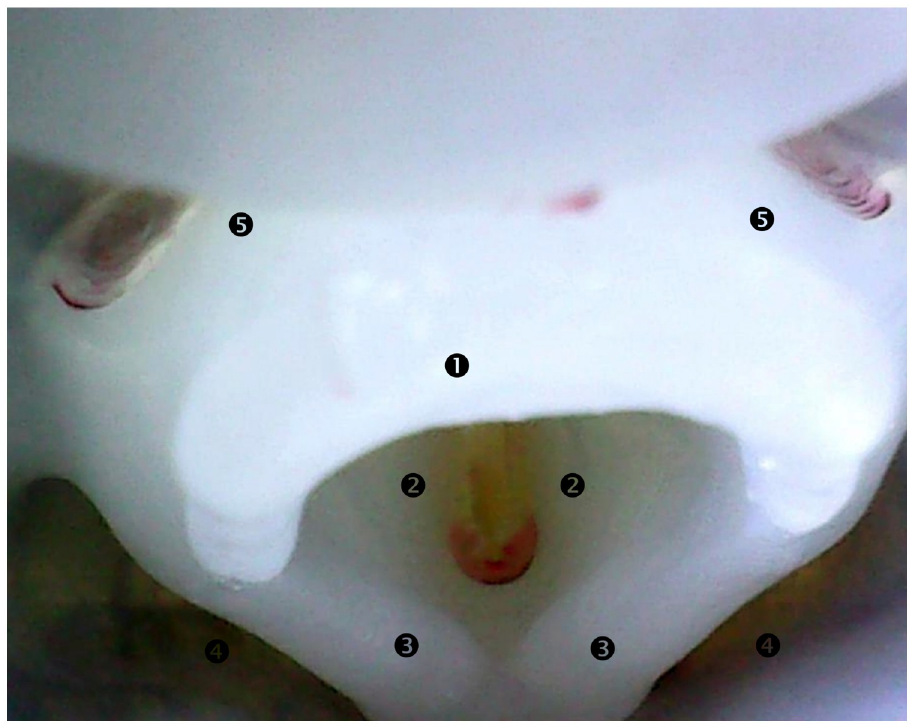
Fig 6. Endoscopic view of Swall-E pharyngeal cavity. (1) epiglottis; (2) vocal folds (glottis); (3) aryepiglottic folds; (4) piriform sinus; (5) valleculae.